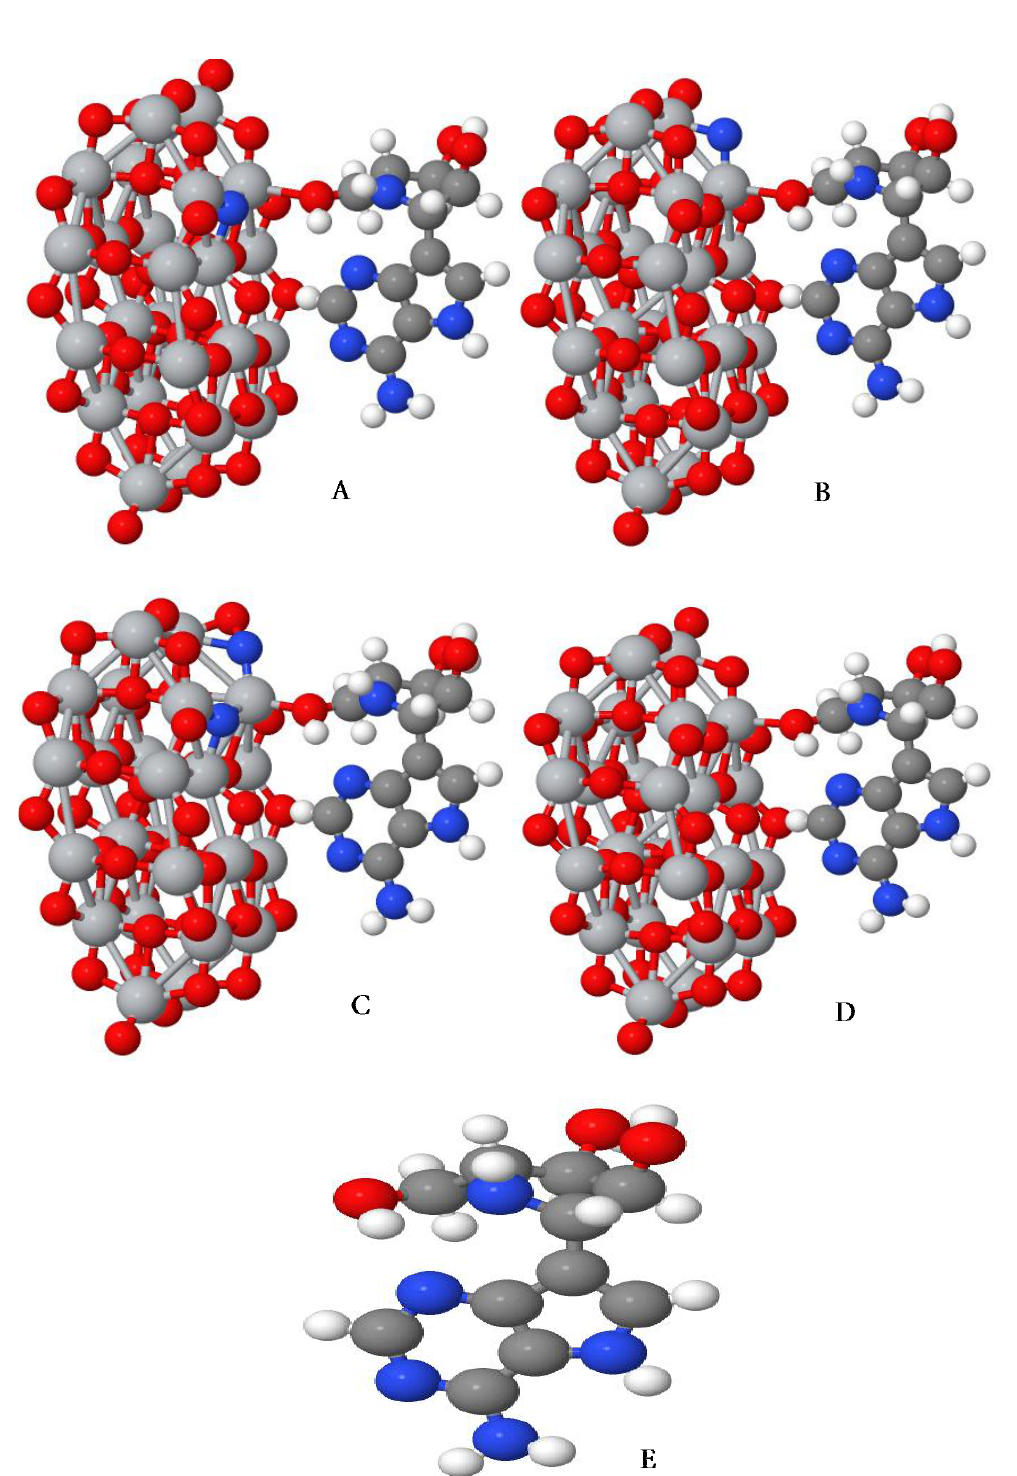
Fig. 3. Optimized geometry configurations of IMMUCILLIN-A drugs adsorbed on the undoped and N-doped TiO ticles. Colours represent atoms accordingly, Ti in grey, O in red, N in blue and H in white. (A): drug adsorbed on the OC-substitut- ed nanoparticle; (B): drug adsorbed on the OT-substituted nanoparticle; (C): drug adsorbed on the OC, T-substituted nanoparticle (2N-doped); (D): drug adsorbed on the undoped nanoparticle; (E): IMMUCILLIN-A